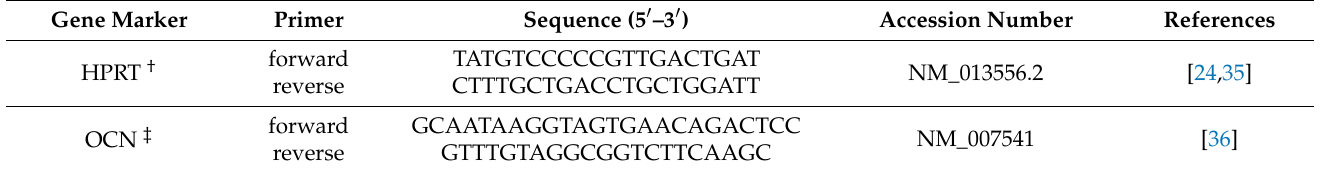
Table 1. Primers used in the gene expression analysis with reverse transcriptase quantitative poly- merase chain